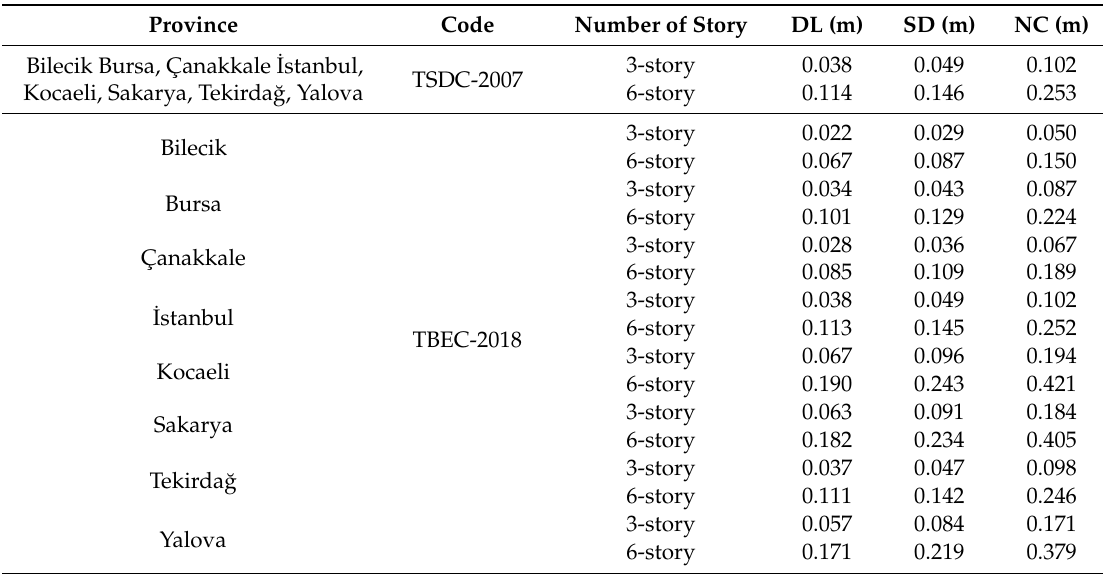
Table 11. Comparison of target displacements for damage estimation according to previous and updated